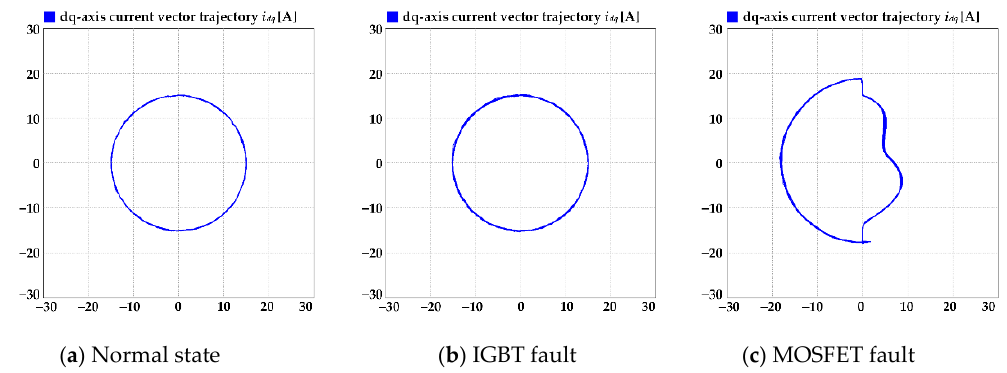
Figure 7. Current vector trajectory in stationary reference frame.